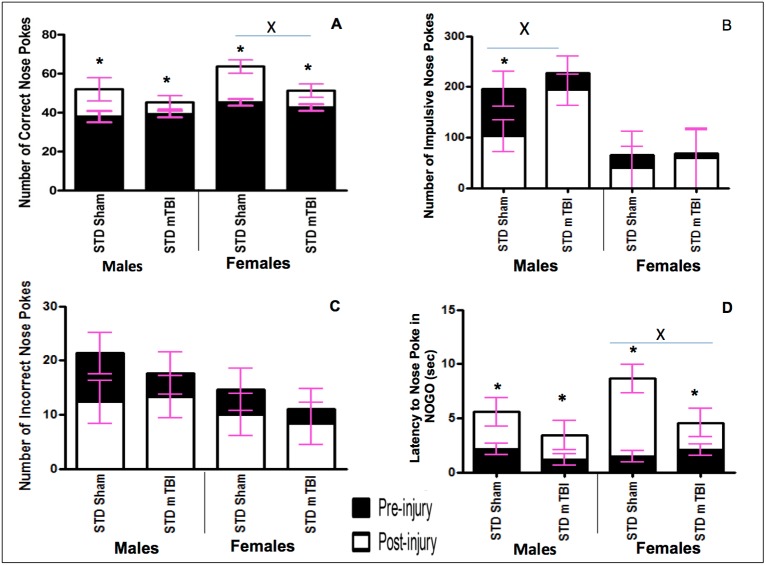
Graphical representation of Go/No-Go results.A) Accuracy, B) Impulsivity, C) Inaccuracy, and D) Response Inhibition, for male and female animals from the STD cohorts at the pre-injury (black bars) and post-injury (white bars) test sessions (x significant effect of mTBI, * significant effect of testing period, all p < .05).